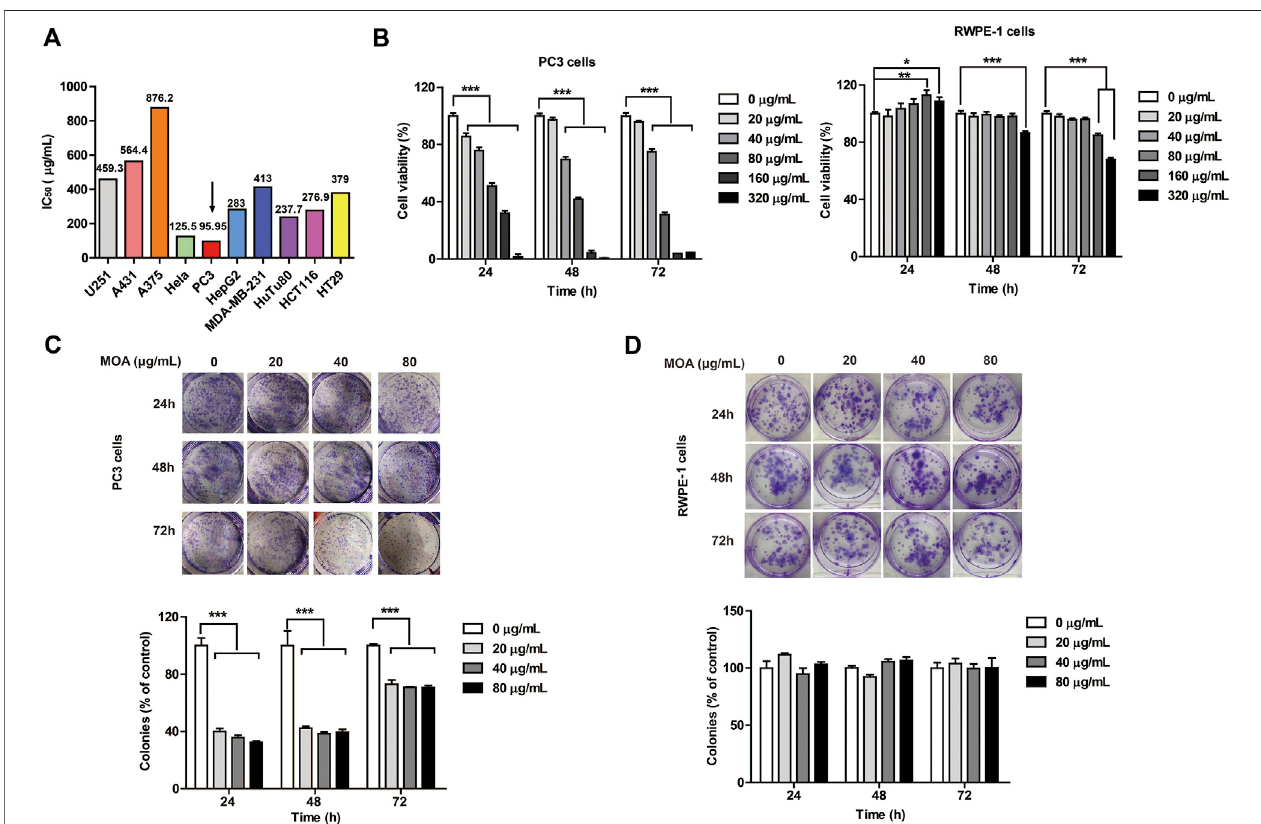
FIGURE 1 | The effect of MOA on the proliferation of PC3 and RWPE-1 cells. (A) The half maximal inhibitory concentration (IC 50 ) of ten tumor cell lines following treatment with MOA (0 – 320 μ g/ml) for 48 h. (B) Cell viability ofPC3 and RWPE-1 cells following MOA (0 – 320 μ g/ml) treatment for 24, 48, and 72h. (C,D) Analysisof the colonyformationabilityofPC3cellsfollowingtreatmentwithMOA(0,20,40,and80 μ g/ml)for24,48,and72h.Thecellularcolonyformationratesareexpressedasfold changes. Results are expressed as the mean ± SEM of three independent experiments. *** p < 0.001 vs. 0 μ g/ml.